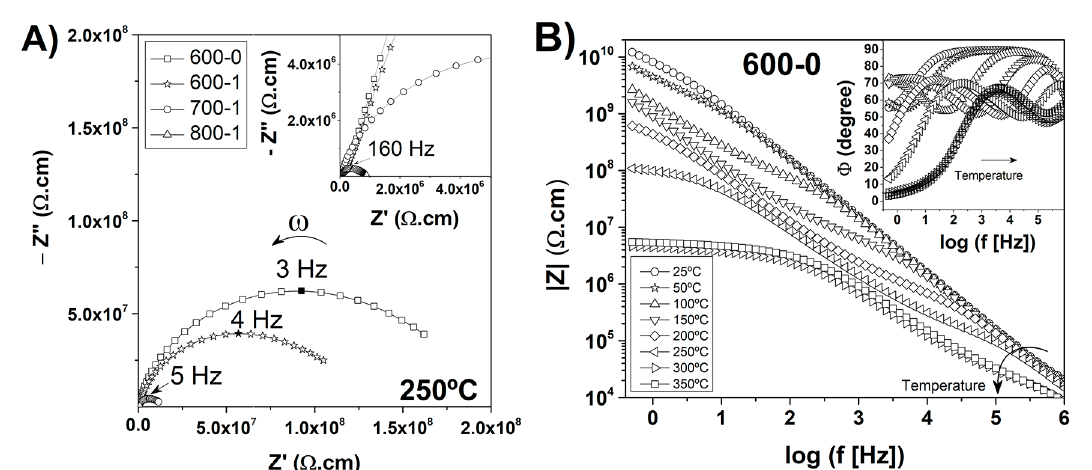
Ti O ceramics: A) Nyquist plot comparing the samples at 250ºC; B) Bode diagram of sample 4 3 12